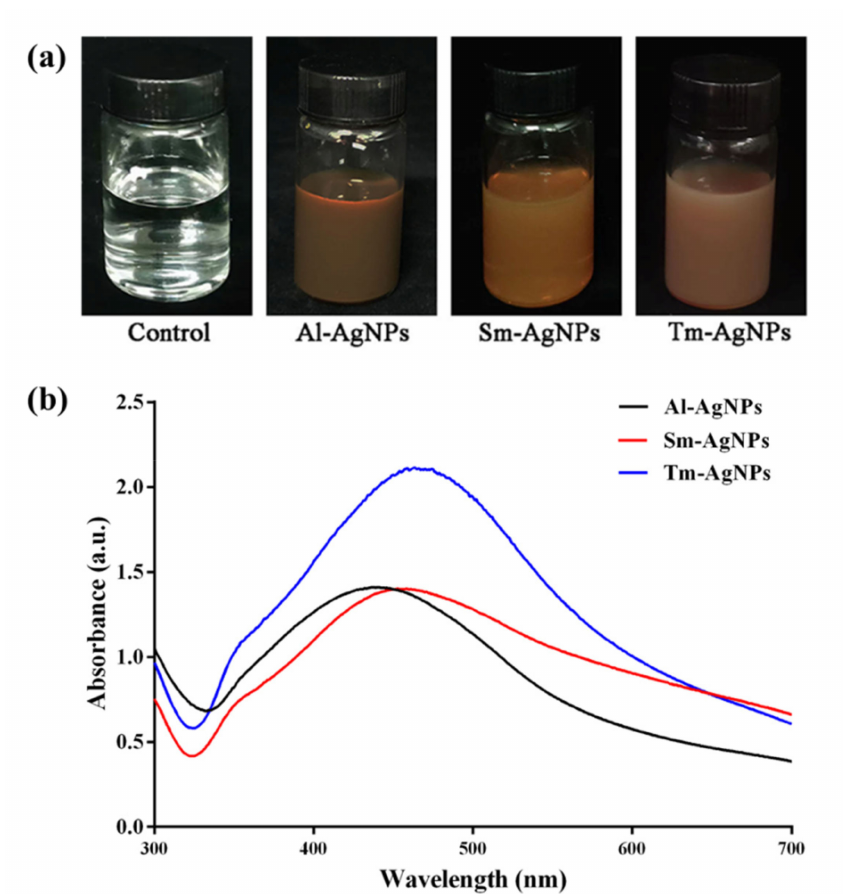
Figure 1. The synthesis of Al-AgNPs, Sm-AgNPs and Tm-AgNPs. ( a ) The color changes in the solutions. ( b ) UV-Visible